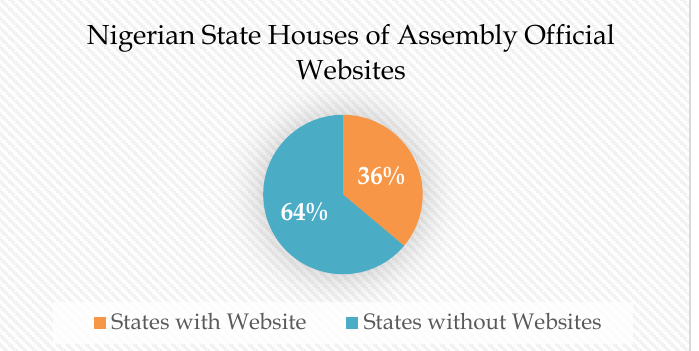
Figure 1: Nigerian State Houses of Assembly Official